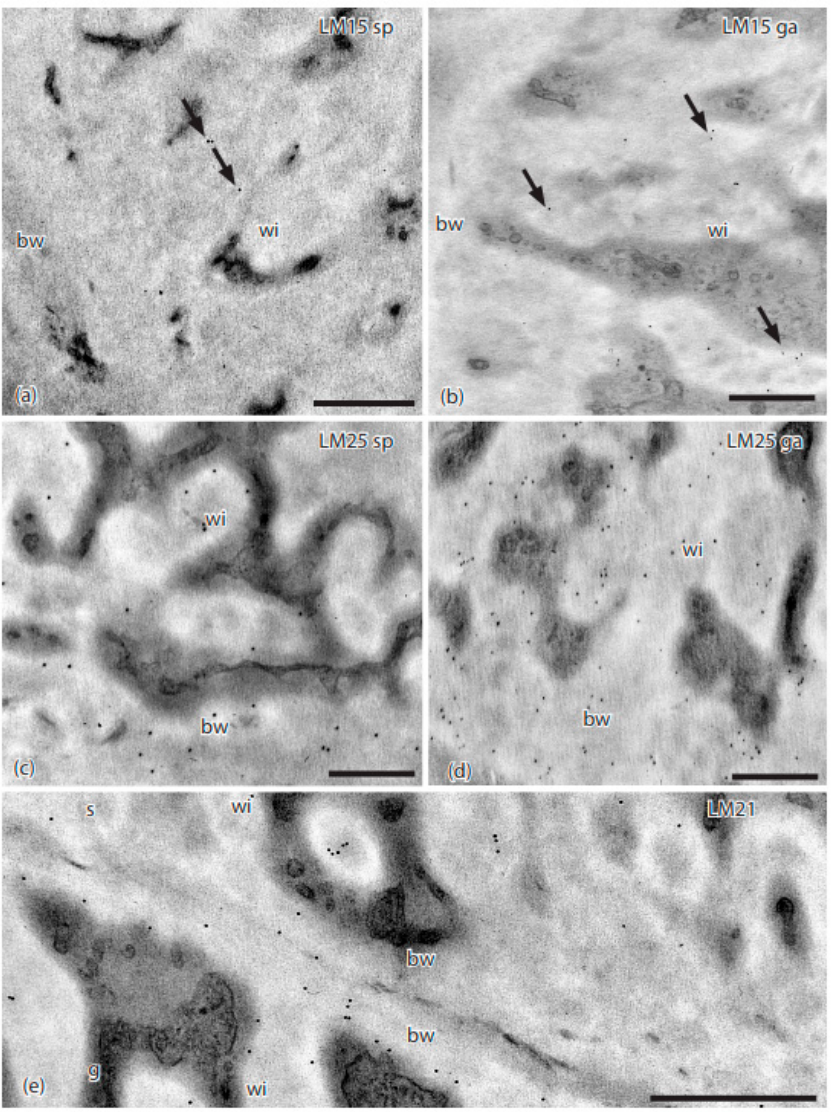
Figure 4. TEMs of Physcomitrium patens placenta showing immunogold labeling with monoclonal antibodies to hemicellulose epitopes. ( a ) LM15 did not label the basal wall (bw), and sparsely labeled (arrows) the sporophyte cell wall ingrowths (wi). ( b ) LM15 did not label the basal wall (bw), and sparsely labeled (arrows) the gametophyte cell wall ingrowths (wi). ( c ) LM25 labeled sporophyte placental cell wall ingrowths (wi) and the basal wall (bw). ( d ) LM25 labeled gametophyte placental cell wall ingrowths (wi) and the basal wall (bw). ( e ) LM21 labeled sporophyte (s) and gametophyte (g) transfer cell wall ingrowths (wi) and basal walls (bw). Scale bars = 0.5 µ